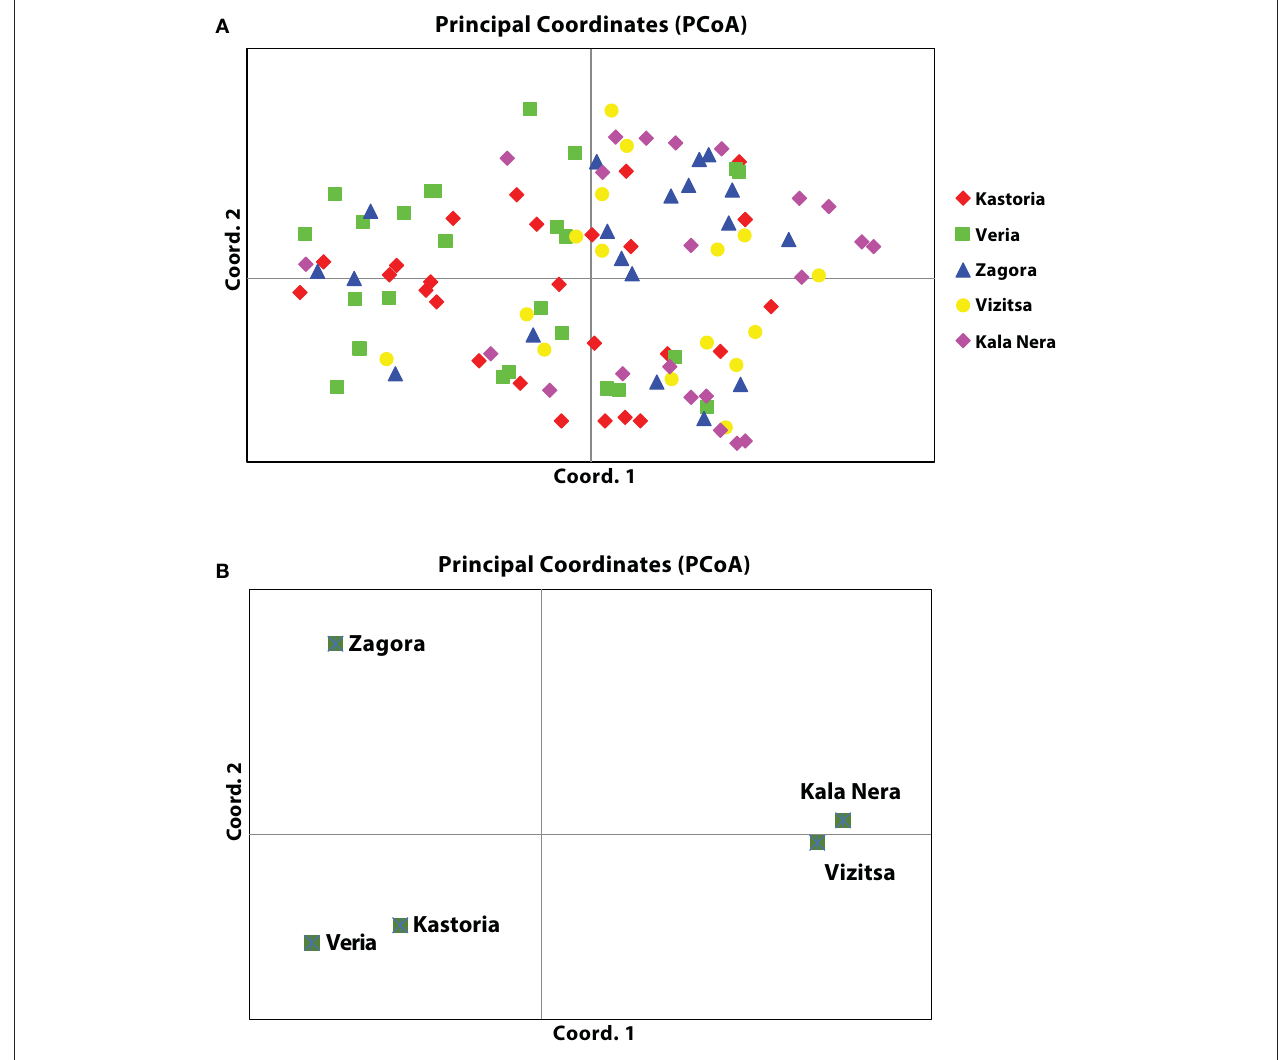
FIGURE 2 | Genetic relationships of five populations of V. inaequalis based on SSR-HRM markers. (A) Principal coordinate analysis (PCoA) of 110 individuals in five populations of V. inaequalis based on 46 polymorphic SSR-HRM loci. 18.01% of total variance accumulated on the first two components (axis 1 = 9.33%; axis 2 = 8.68%). (B) Collapsed PCoA depicting relationships among populations (axis 1 = 51.81%; axis 2 = 26.33%). Samples included are indicated after population